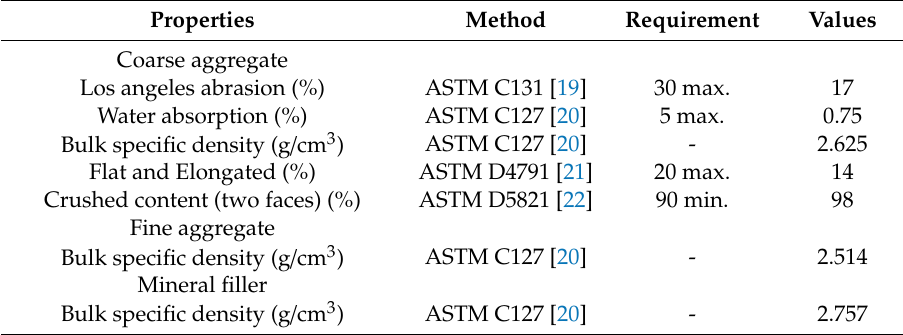
Table 1. The Properties of